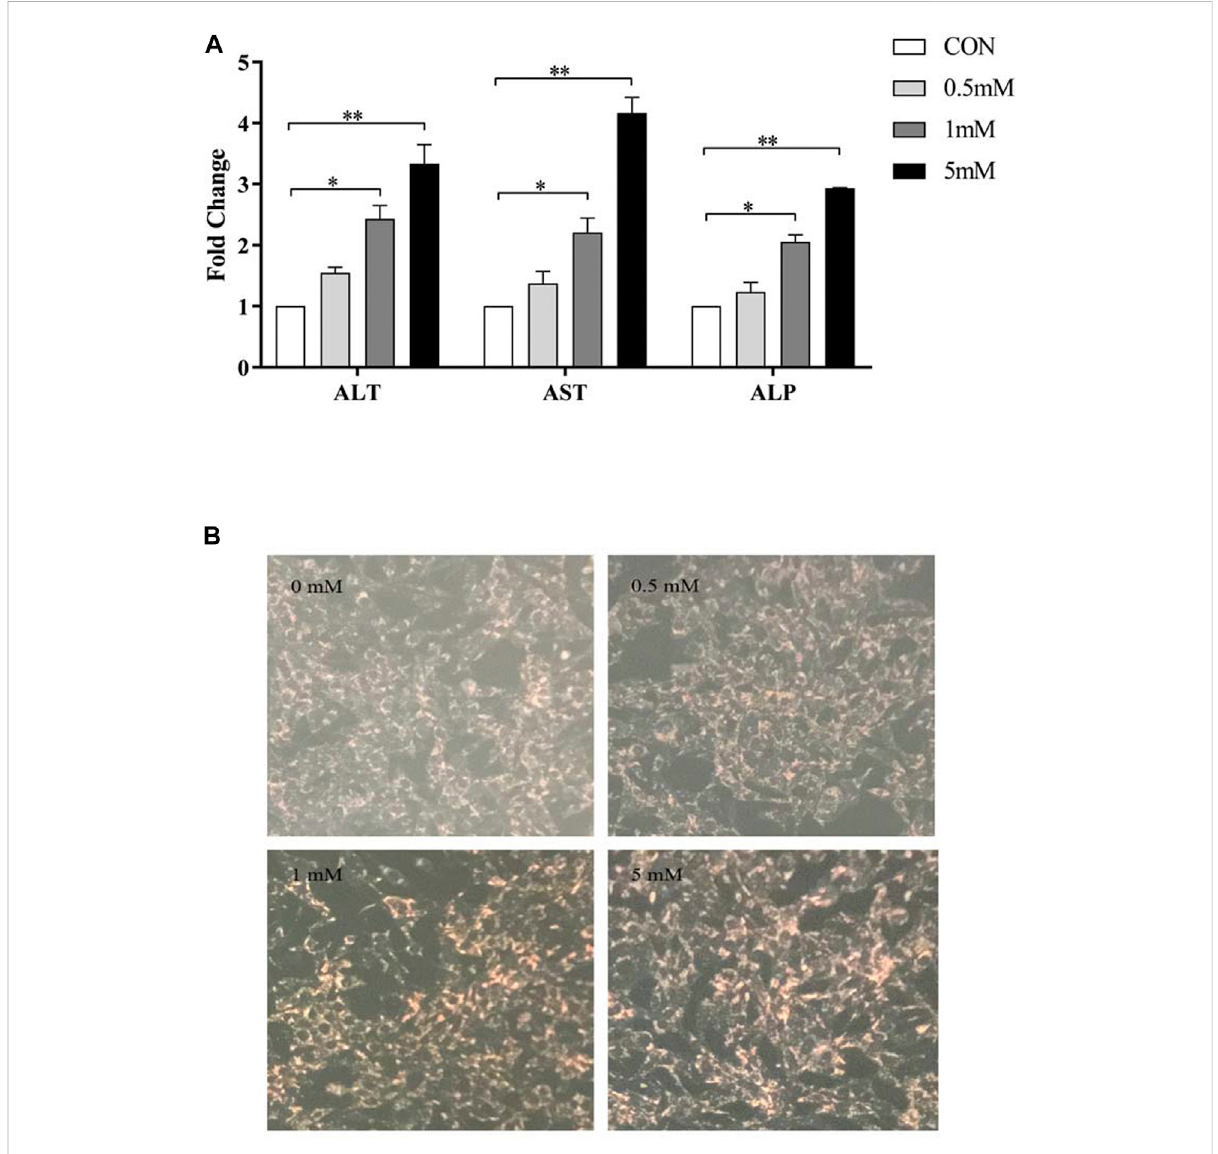
FIGURE 5 ToxiceffectsofdifferentconcentrationsofVPAonLO2cells. (A) EffectsofdifferentconcentrationsofVPA(0,0.5,1,5 mM)onALT,ASTandALP enzyme activities in LO2 cells; (B) Oil red O staining to observe the effects of different concentrations of VPA (0, 0.5, 1, 5 mM) on intracellular lipid levels in LO2 cells, data are expressed as mean ± SEM ( n = 3). *p < 0.05, **p <